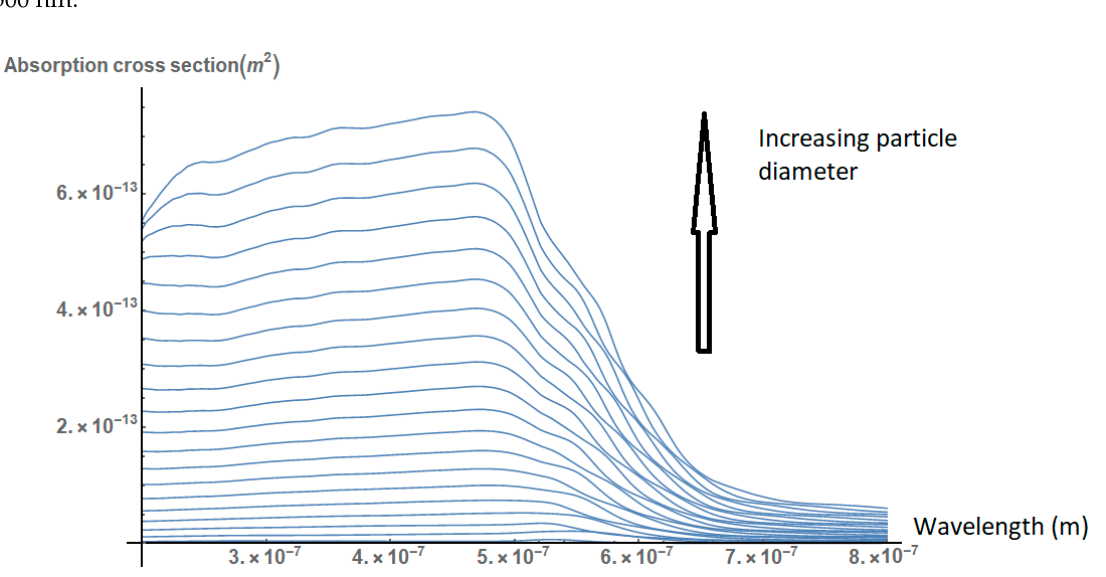
Figure 2. The absorption cross section of gold nanoparticles as a function of their diameter. The red line is a fitting curve based on the function y = α x p , where α = 2.9 × 10 –4 and p = 1.46. The incident wavelength is assumed to be 532 nm, which is a common laser wavelength corresponding to the second harmonic of Nd:YAG lasers and is also in the region of maximum absorption of gold nanoparticles. We have also studied the behavior of the absorption efficiency of a nanoshell consisting of a silica core surrounded by a gold layer, as in the case of the hyperthermia simulations. Τ he absorption spectrum of the nanoshell appears to be red-shifted as the thickness of the gold layer decreases (Figure 3).